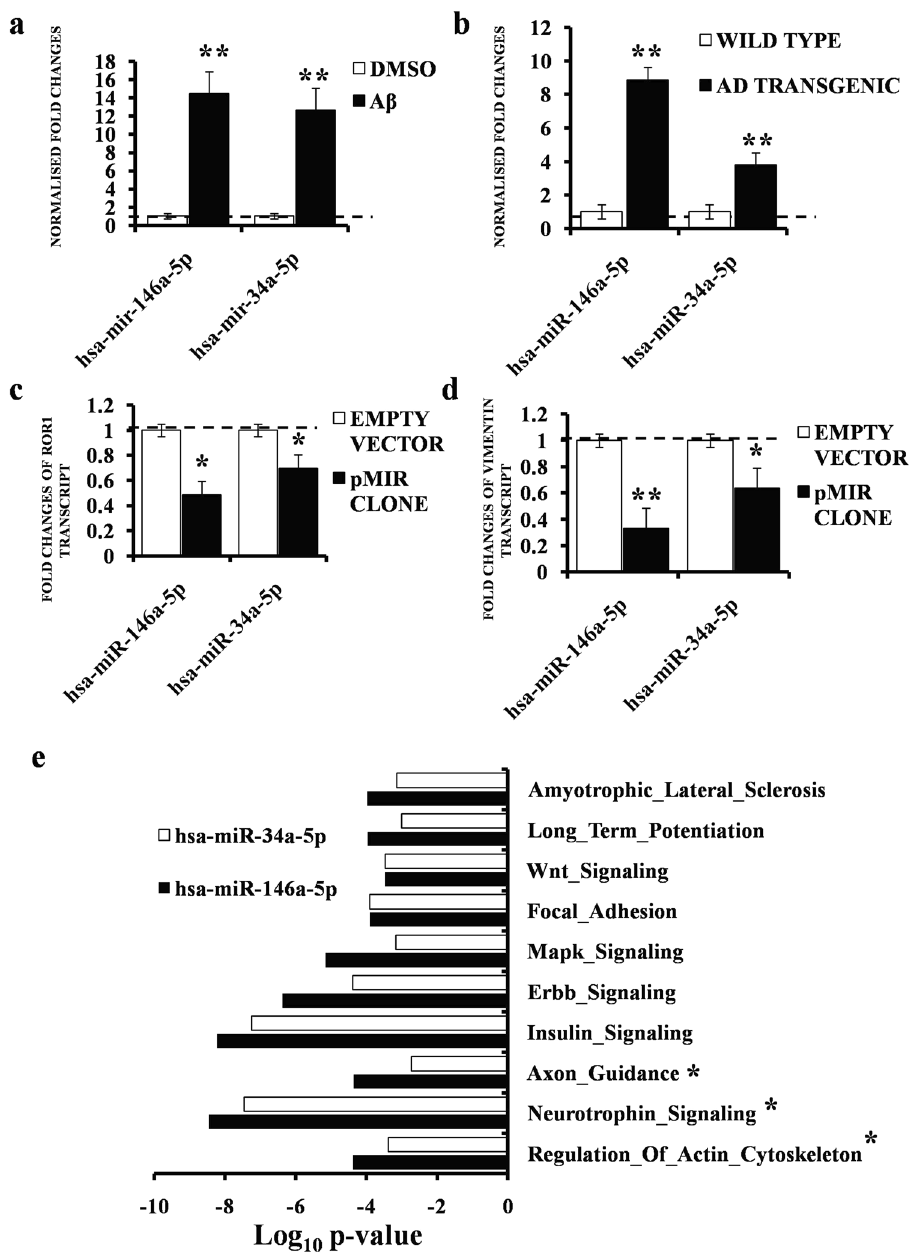
Figure 4. Dysregulation of hsa-mir-146a-5p, hsa-mir-34a-5p in Aβ 1–42 treated cell model and mice AD model. ( a ) Graph depicting three (n = 3) independent biological replicates quantifying levels of hsa-mir-146a and hsa-mir-34a by qRT-PCR in SHSY-5Y cells treated with 1 µM Aβ 1–42 or treated with only DMSO. ( b ) Graph depicting three (n = 3) independent biological replicates quantifying levels of hsa-mir-146a and hsa-mir-34a by qRT-PCR in transgenic AD mice or age matched wild type mice brain tissues. ( c ) Graph depicting three (n = 3) independent biological replicates quantifying levels of ROR1 by qRT-PCR in SHSY-5Y cells treated with hsa-mir-146a-5p and hsa-mir-34a-5p pMIR clones or corresponding empty vector controls. ( d ) Graph depicting three (n = 3) independent biological replicates quantifying levels of Vimentin by qRT-PCR in SHSY-5Y cells treated with hsa-mir-146a-5p and hsa-mir-34a-5p pMIR clones or corresponding empty vector controls. Levels of U6snRNA were taken as endogenous control for the miRNAs and levels of GAPDH were taken as endogenous control for the mRNA levels. The levels of individual miRNAs or mRNA were normalized by the corresponding U6snRNA or GAPDH levels. Fold changes were computed by considering the relative levels of lncRNA in corresponding controls to be 1. Error bars indicate ± SD. Significance level between different experimental pairs is shown (NS, not significant; * p < 0.05; ** p < 0.01; *** p < 0.001). ( e ) KEGG analysis of the 2 de regulated miRNAs; bar graphs indicate Log ( p value) and ranges from (-)10 to 0. Pathways deregulated in AD are marked with an